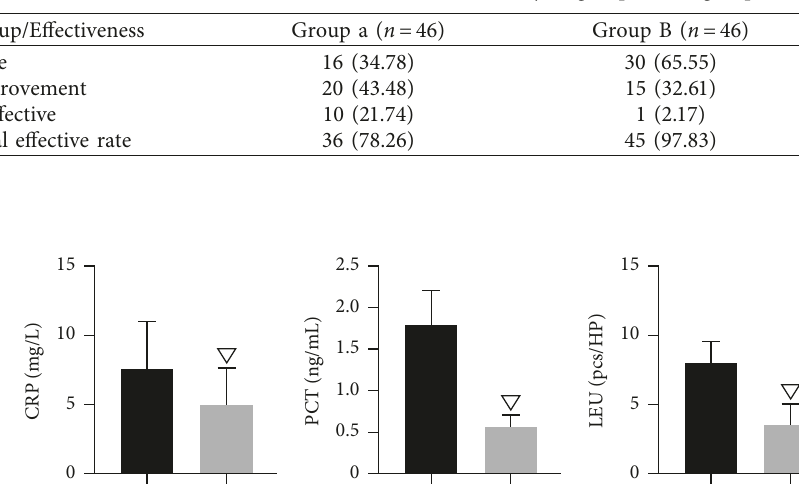
Figure 1: Comparison of serum and urine indexes before treatment in the three groups. Contents in (a–d) are CRP, PCT, LEU, and BACT, respectively. ▲ P < 0 . 05 compared with the control group. Table 2: Clinical efficacy of group A and group B ( n , %).